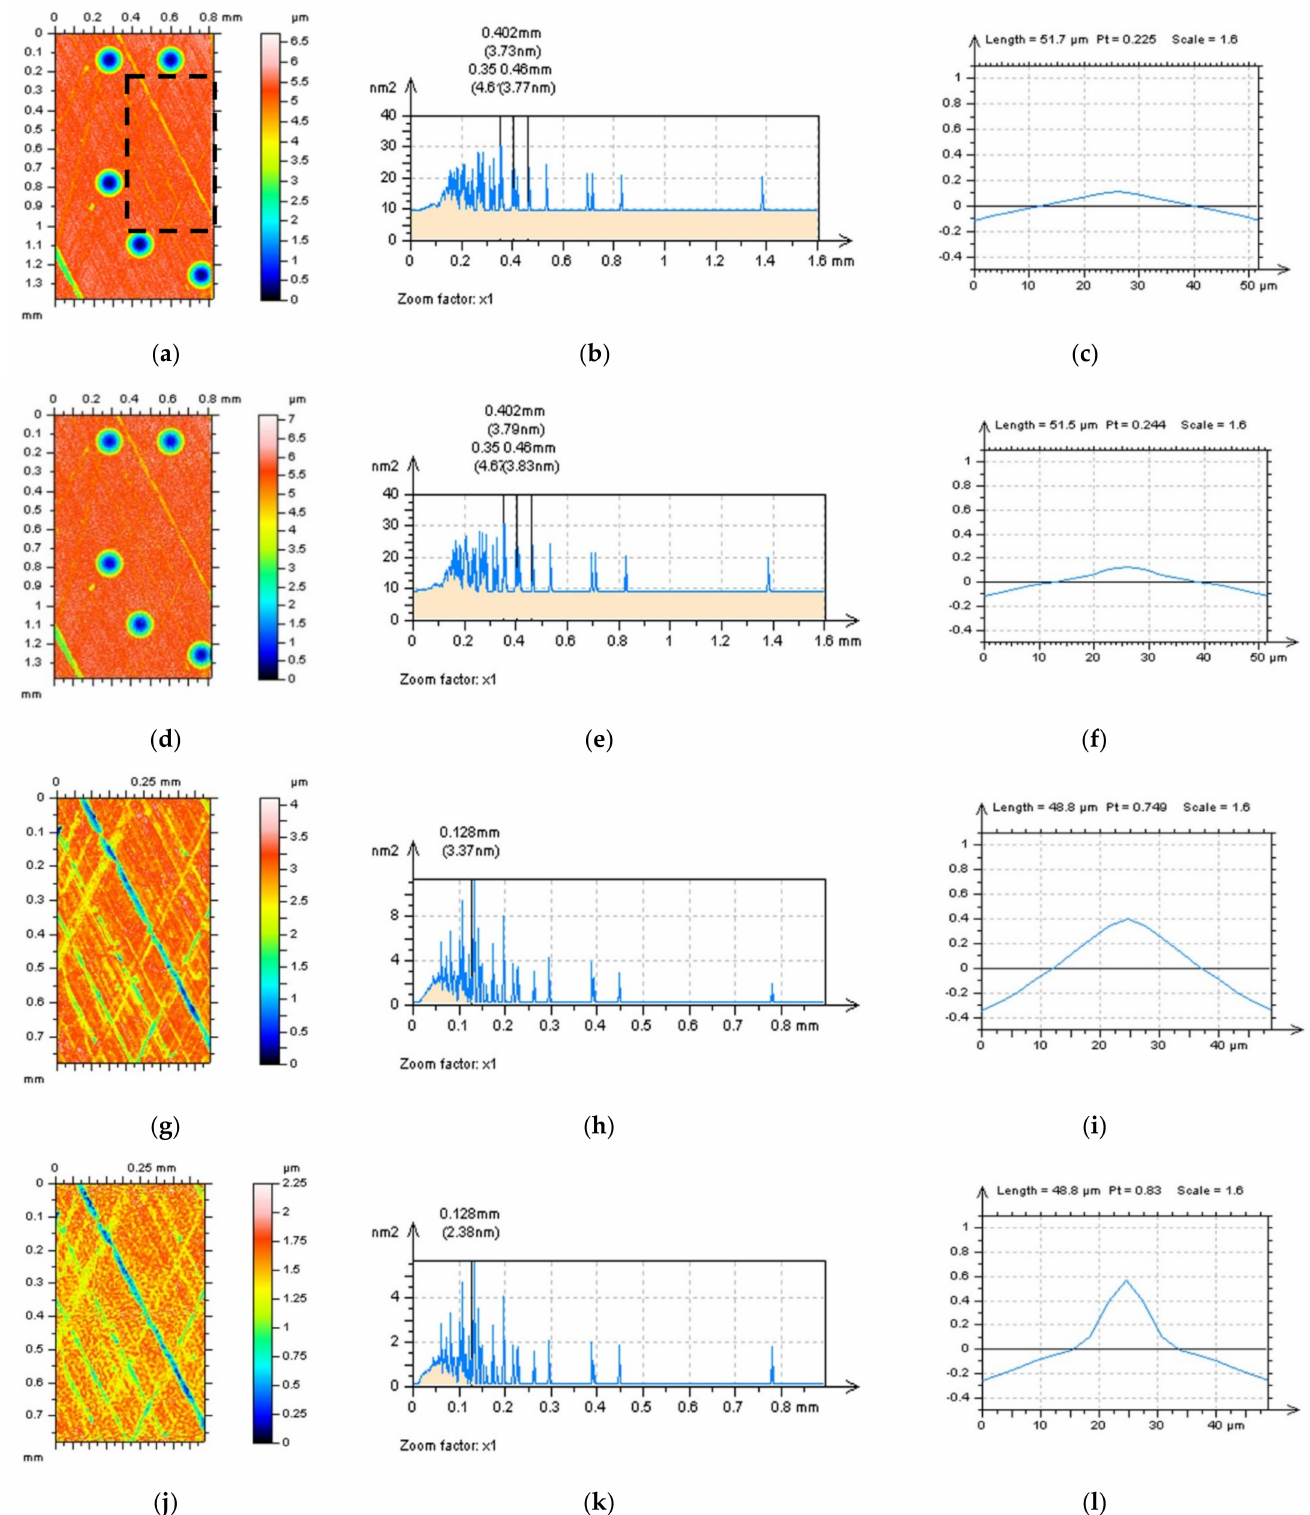
Figure 11. Plateau-honed cylinder liner with additionally burnished dimples (oil pockets) ( a – f ) and FOD detail ( g – l ) extracted from surface presented in ( d ), contour map plots ( a , d , g , j ), PSDs ( b , e , h , k ) and ACFs ( c , f , i , l ), the analysis proposed for raw measured surface data ( a – c , g – i ) and data with modelled high-frequency errors ( c – f , j – l